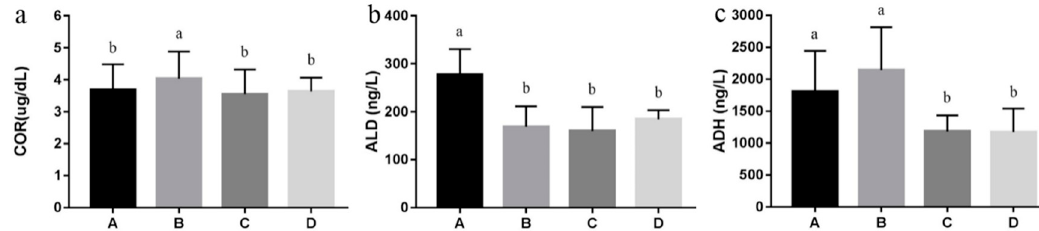
Figure 1. Effect of betaine on endocrine hormones of high-salt stressed Sprague–Dawley rats ( n = 8 in